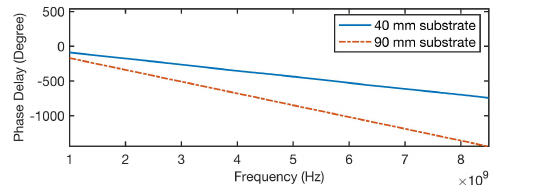
Figure 4. Phase delays of rectangular infill pattern (80% infill density) vs. frequency.